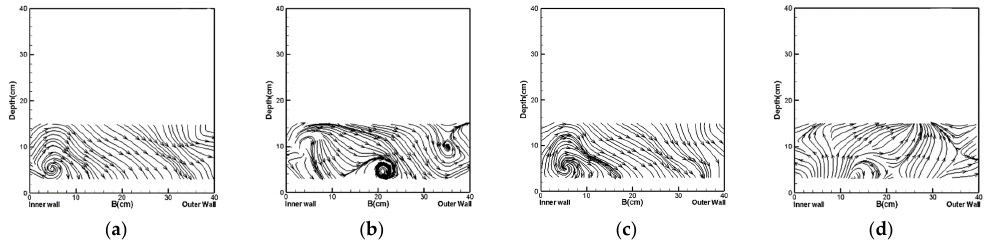
Figure 10. The latitudinal distribution of velocity at 90 degrees with and without a W − Weir, ( a ) Fr = 0.17 with a W − Weir ( b ) Fr = 0.17 without a W − Weir, ( c ) Fr = 0.28 with a W − Weir, and ( d ) Fr = 0.28 without a W − Weir.